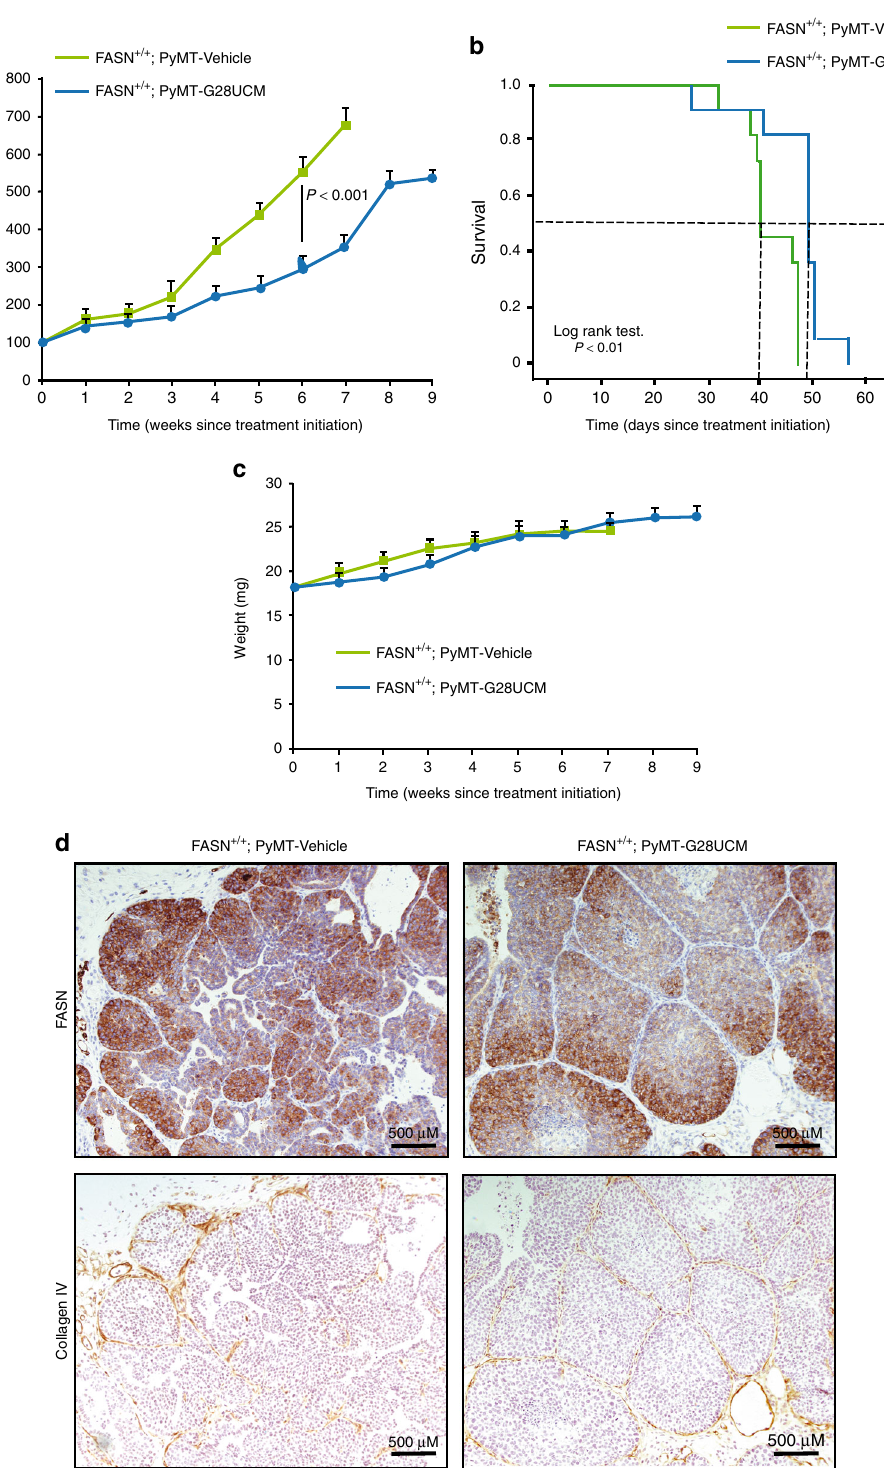
Fig. 7 FASN inhibition prevents the development of invasive ductal carcinoma. a Inhibitory effects of G28UCM on tumor growth in MMTV-PyMT animals. Presented data are the mean values ± SEM ( n = 11 mice per group). *** P < 0.001; Student ’ s t test. b Kaplan – Meier survival curves of mice treated with either vehicle ( n = 11 mice) or G28UCM agent ( n = 11 mice). Survival was calculated from the time of treatment initiation. Survival is increased in G28UCM-treated mice from 40 to 49 days (log-rank P < 0.01) . c Average animal weight during vehicle ( n = 11 mice) or treatment ( n = 11 mice). d Upper panels: FASN staining in vehicle- or G28UCM-treated breast tumors. Lower panels: collagen IV staining (basement marker) reveals that G28UCM-treated MMTV-PyMT animals develop only noninvasive ductal in situ carcinoma proliferations. Representative images were obtained for each treatment. Scale bar, 500 μ